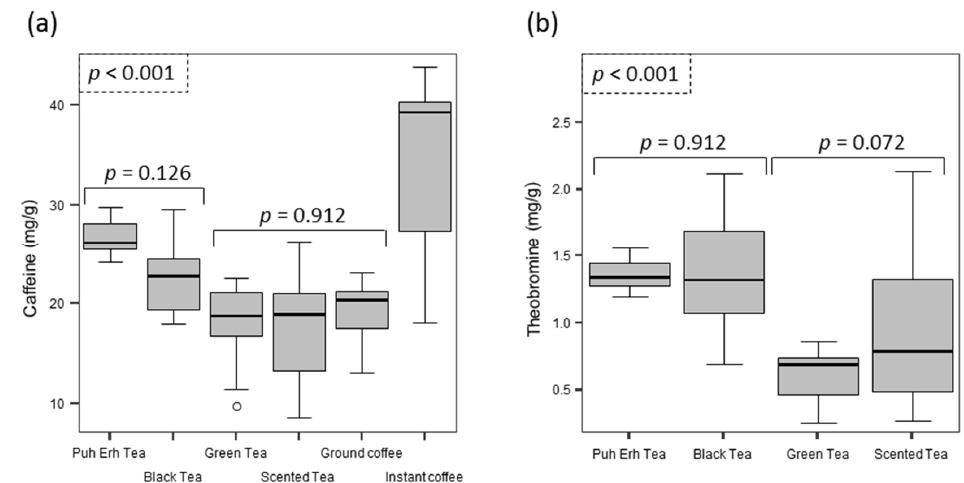
Figure 3. Distribution of the concentrations (in mg/g) of caffeine ( a ) and theobromine ( b ) detected in the different type of tea leaves and coffees evaluated.